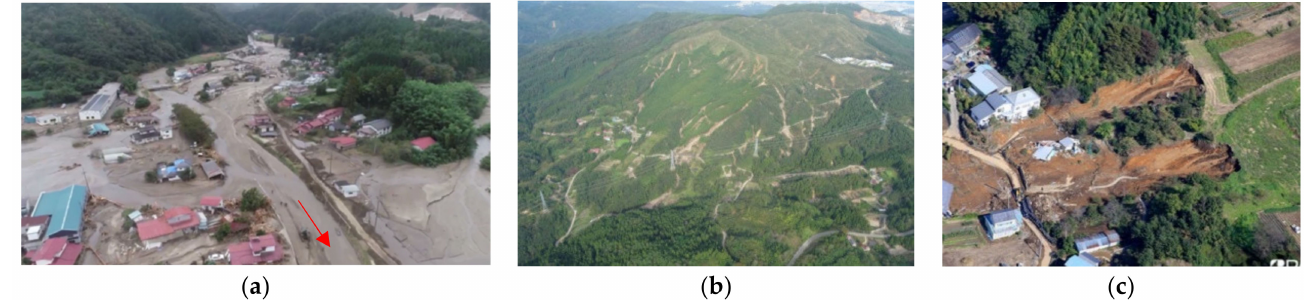
Figure 2. Photos of sediment disasters caused by Typhoon Hagibis 2019: ( a ) sediment-laden flood, ( b ) debris flows in an area where the valley topography was unclear, ( c ) deep-seated landslides in an area where there was no clear deep-seated landslide topography (courtesy of Pasco